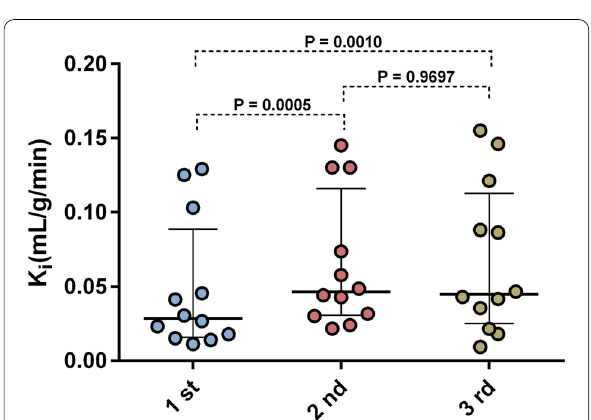
Fig. 4 Scatter dot plots of tumor K i at the first (0 h), second (4 h) and third (7 h) dynamic scan. The solid line represents median and interquartile range. Significant subsequent increases ( P < 0.05) were found in tumor K i between the first and second and first and third dynamic scan, however, not between second and third scan ( P >